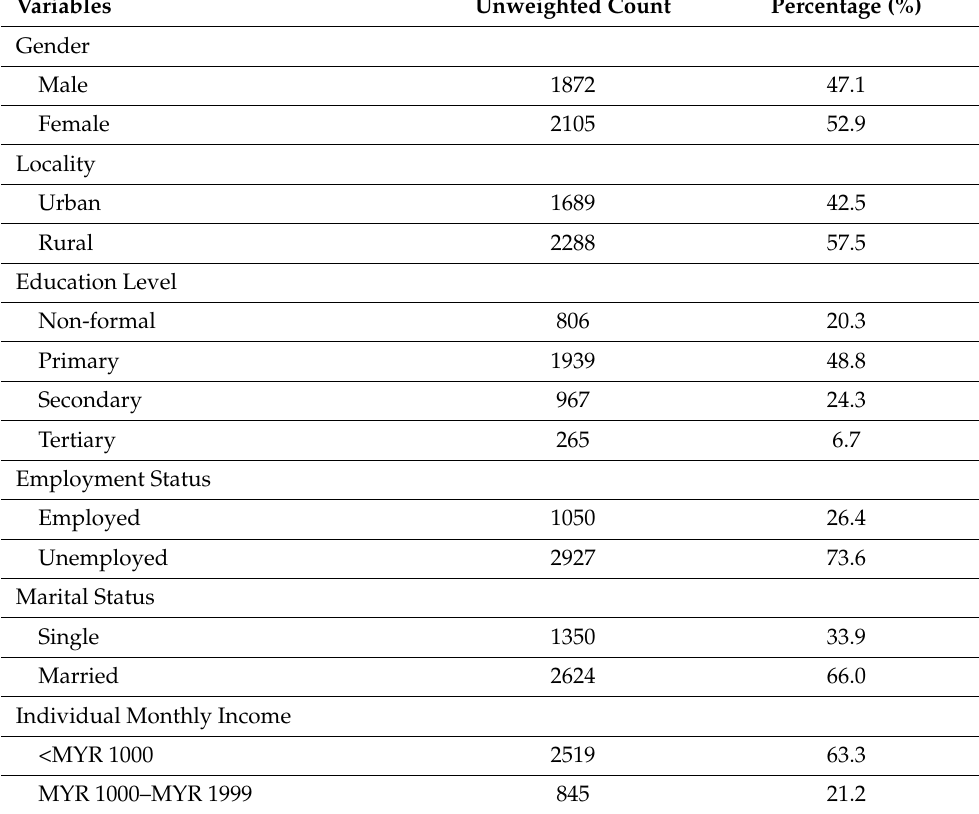
Table 1. Sociodemographic profile of the respondents (n =